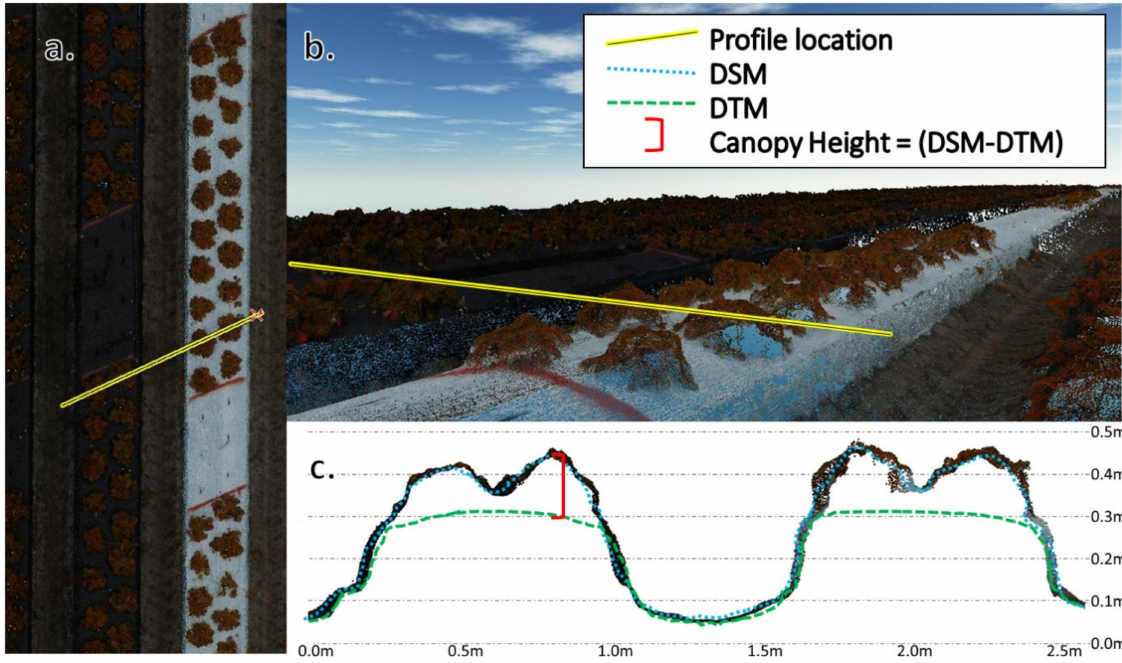
Figure 7. ( a ) Nadir visualization of a point cloud, ( b ) oblique 3D visualization of a point cloud, and ( c ) profile showing canopy height as the difference between DSM (top solid line) and DTM (bottom dashed